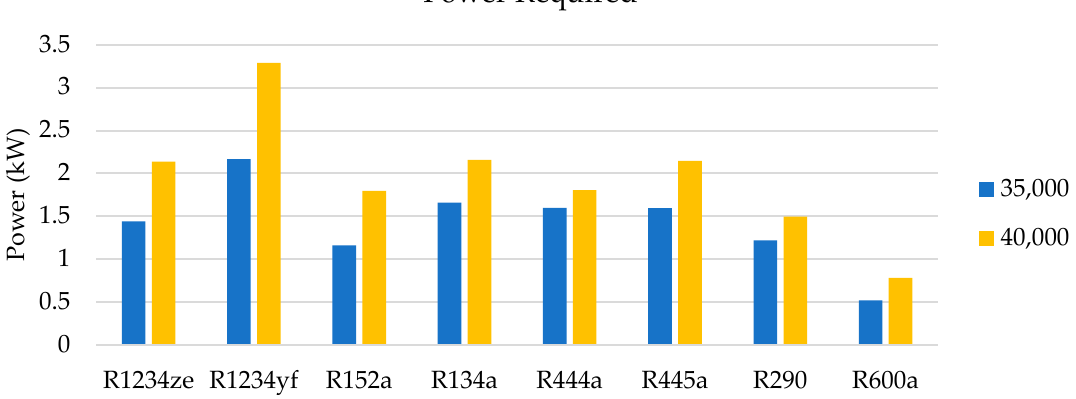
Figure 15. Comparison of Power Required for each Working Fluid at an RPM of 35,000 and